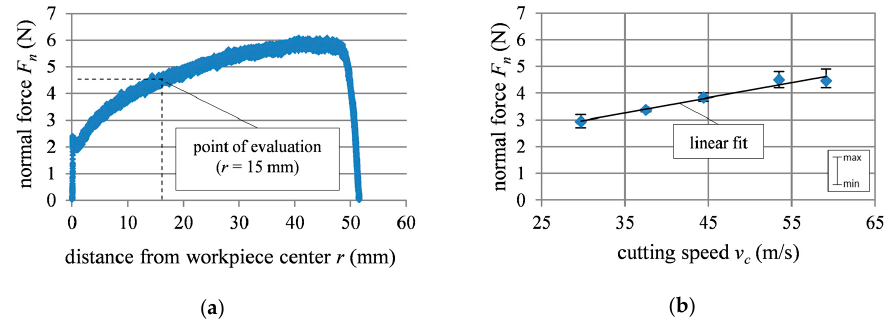
Figure 2. ( a ) Typical force curve ( F n ) at v c = 62 m/s) for constant worktable speed n W ; ( b ) Normal forces for different cutting speeds (distance from workpiece center 15 mm).